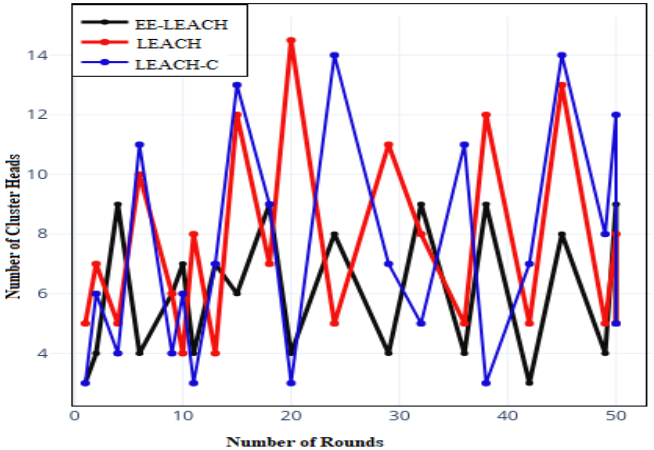
Figure 7. Number of cluster heads vs. number of rounds.